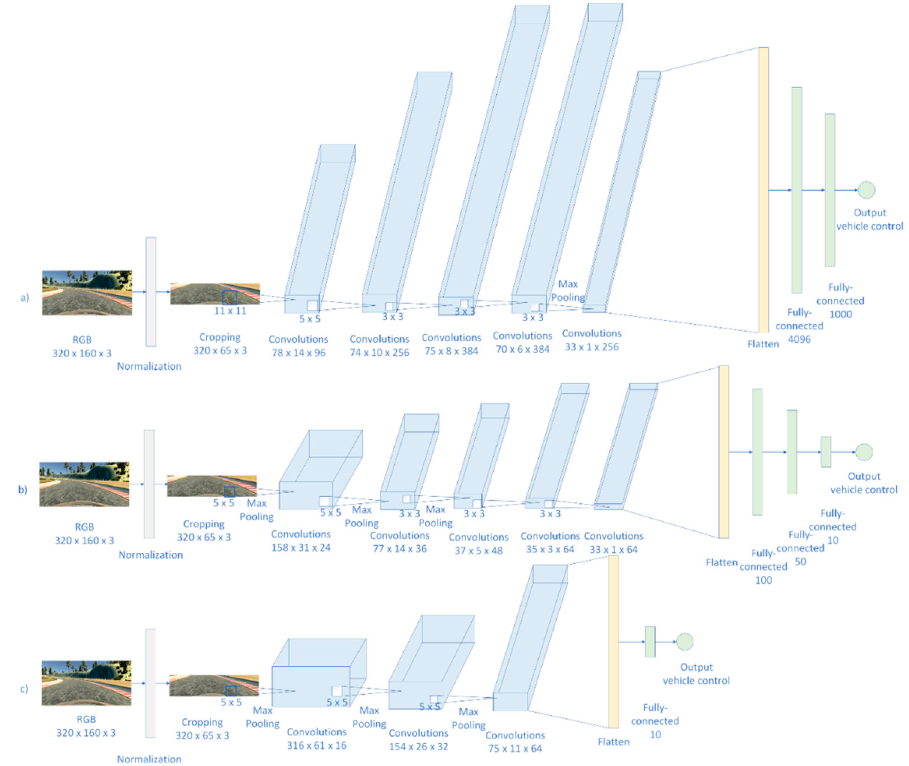
Figure 13. Comparison of deep neural network architectures that we implemented and used for end-to-end autonomous driving: ( a ) AlexNet; ( b ) PilotNet; ( c ) J-Net.